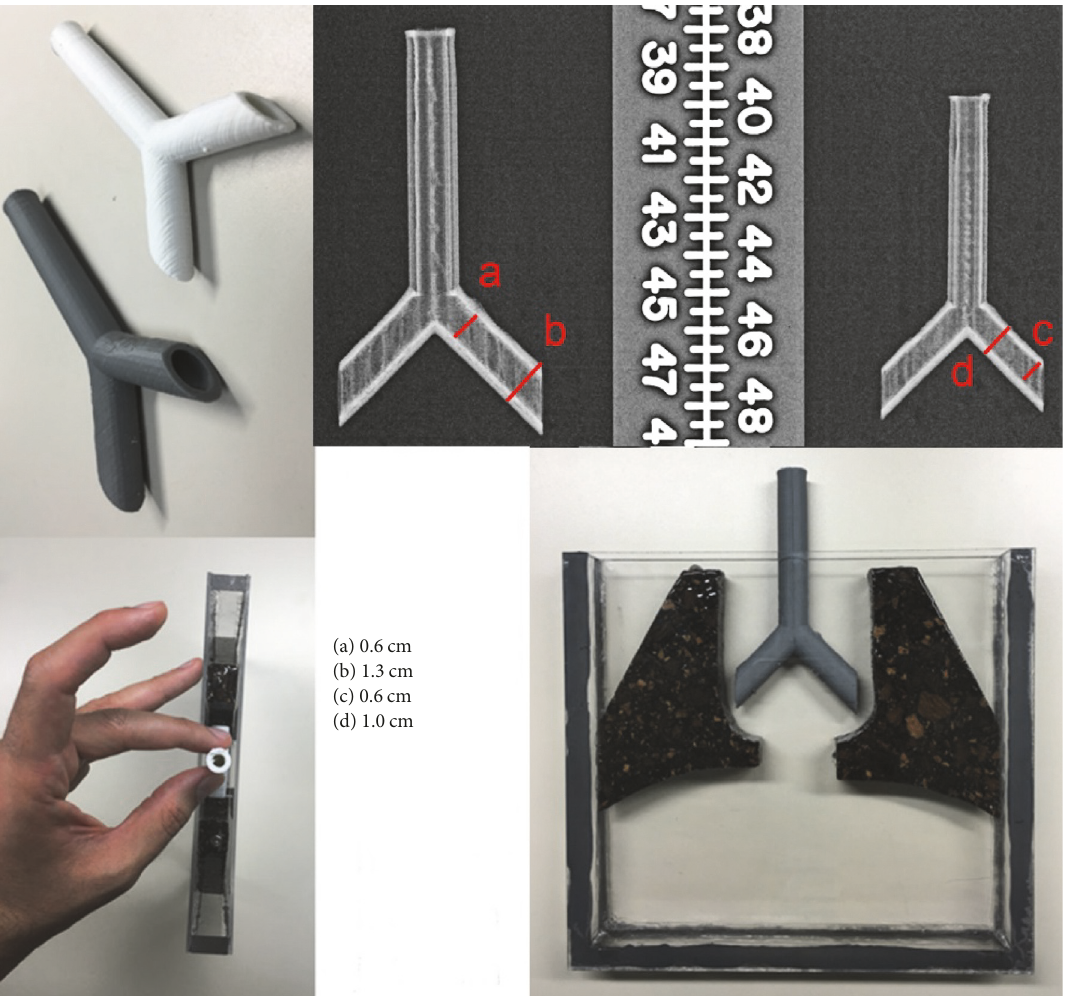
Figure 4: View of the AE components and how they fit within the middle slab of the phantom. Clockwise from top left: multiple copies of two sizes were printed. The linear dimensions are given for the X-ray image with a centimeter scale appearing for comparison. The angle at the carina between the right and the left mainstem bronchi is 90 degrees. The tubes are continuously hollow and sealed airtight before being inserted and imaged as part of the phantom. A side view showing how the airway fits in the middle slab. A 1mm gap between the LE component and the container (lower left image) allows for water to uniformly fill any space not occupied by the LE or AE substitutes. An AP view.